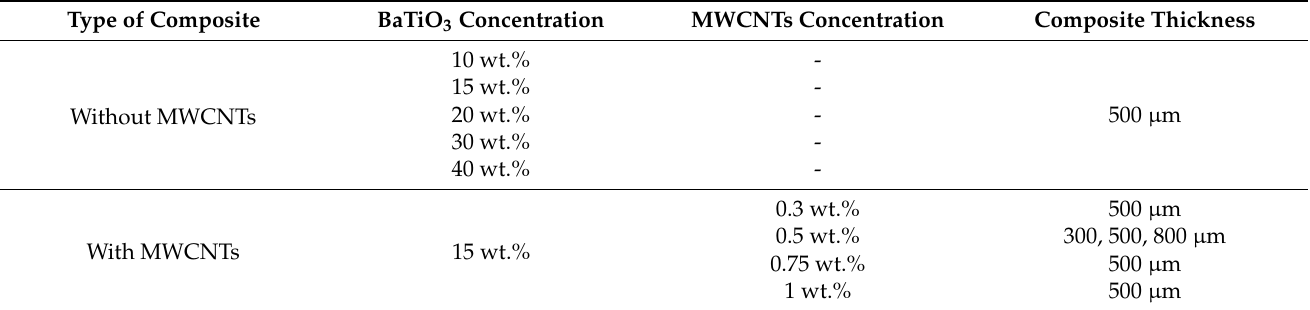
Table 1. Summary of the composites compositions and dimensions realized in this work. Type of